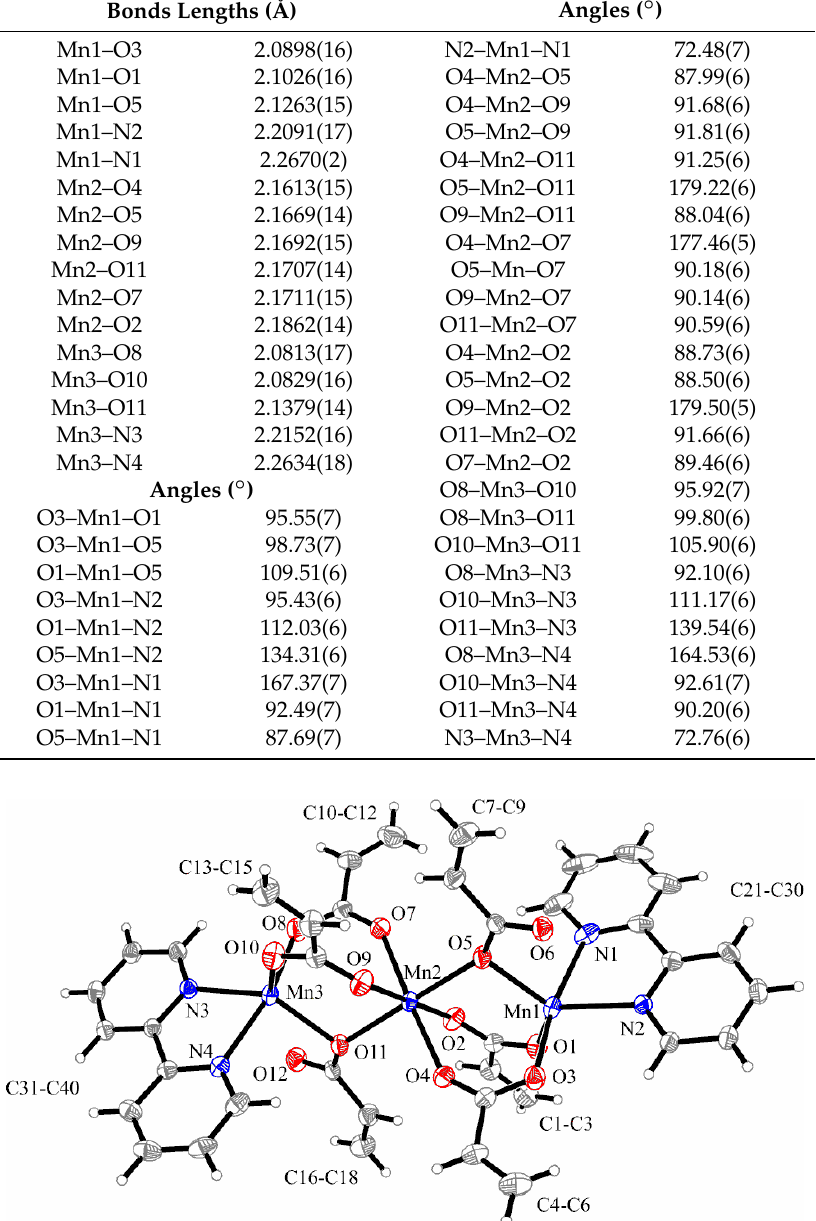
Figure 1. X-ray structure of [Mn 3 (2,2 ′ -bipy) 2 (C 3 H 3 O 2 ) 6 ] ( 1 ). Thermal ellipsoids are shown with 30% probability.